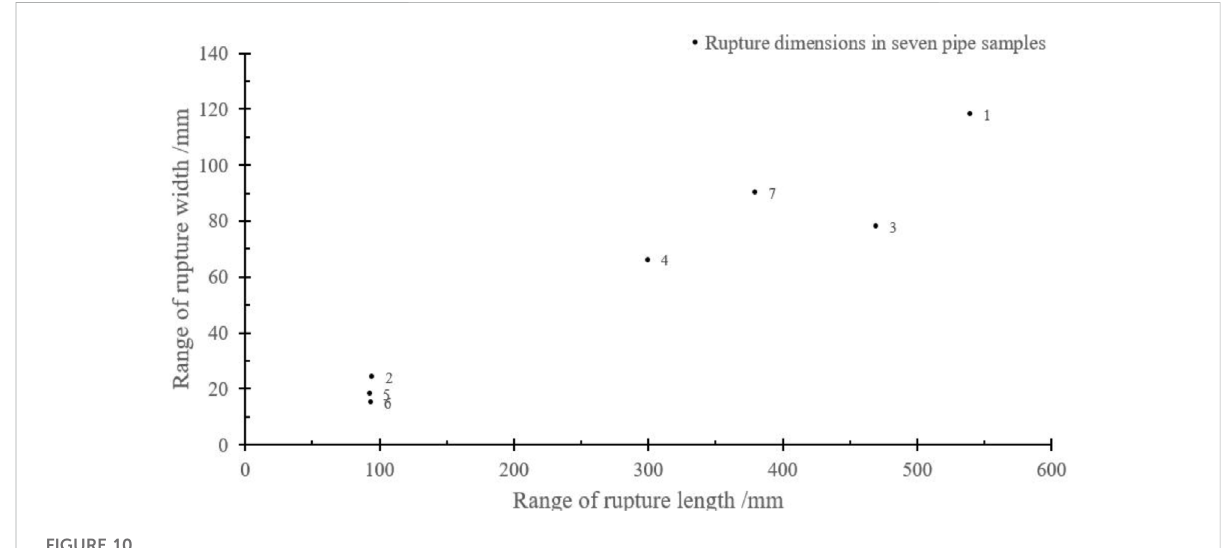
FIGURE 10 Distribution of rupture length and width in seven samples.